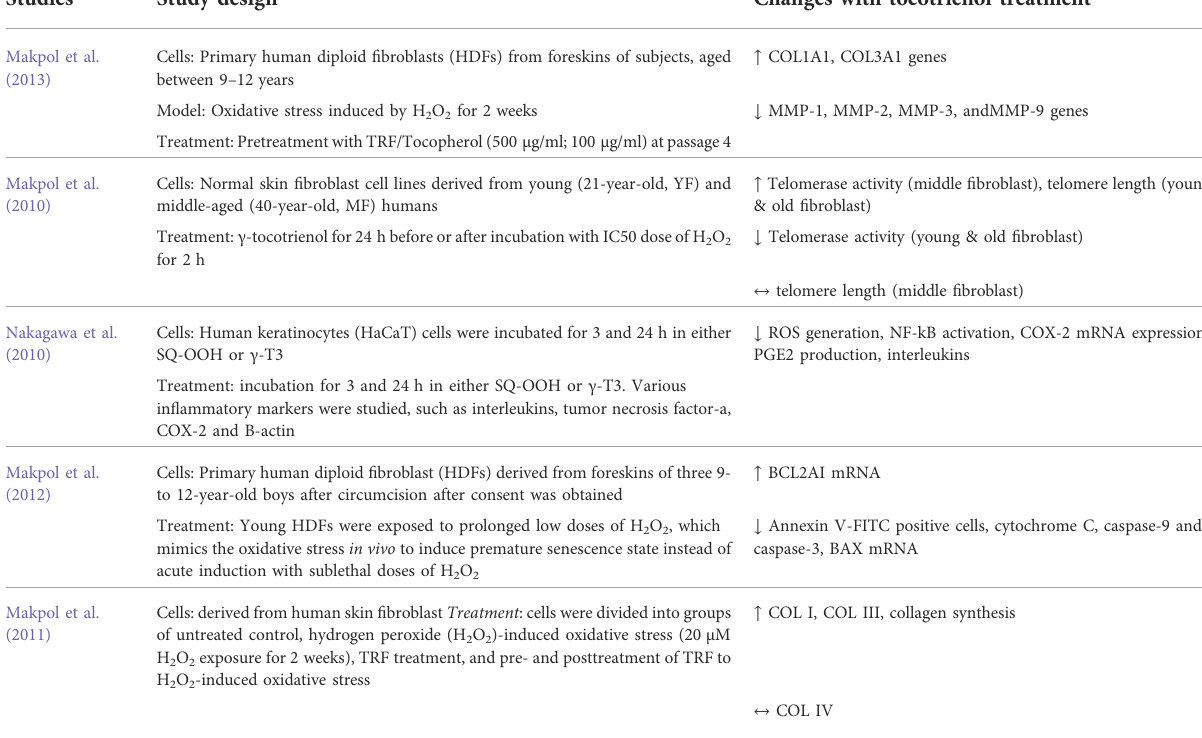
TABLE 1 Effects of tocotrienol on the molecular markers of aging skin.